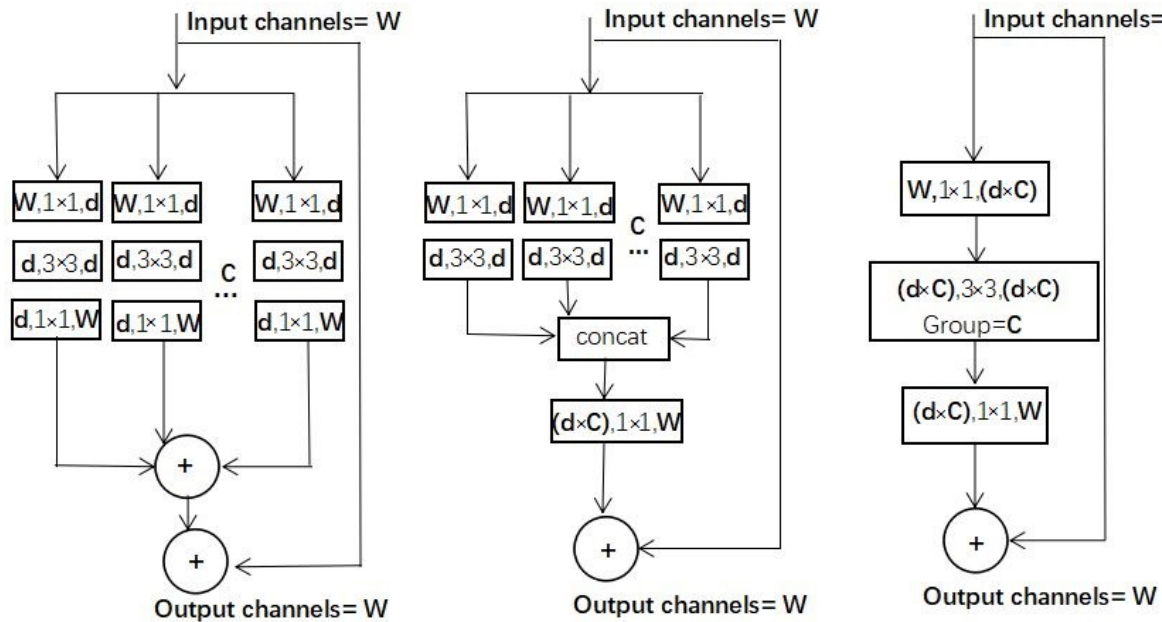
Figure 5. Three forms of ResNeXt [26]. Layers are expressed as (input channels, filter size, and output channels), while C indicates cardinality.